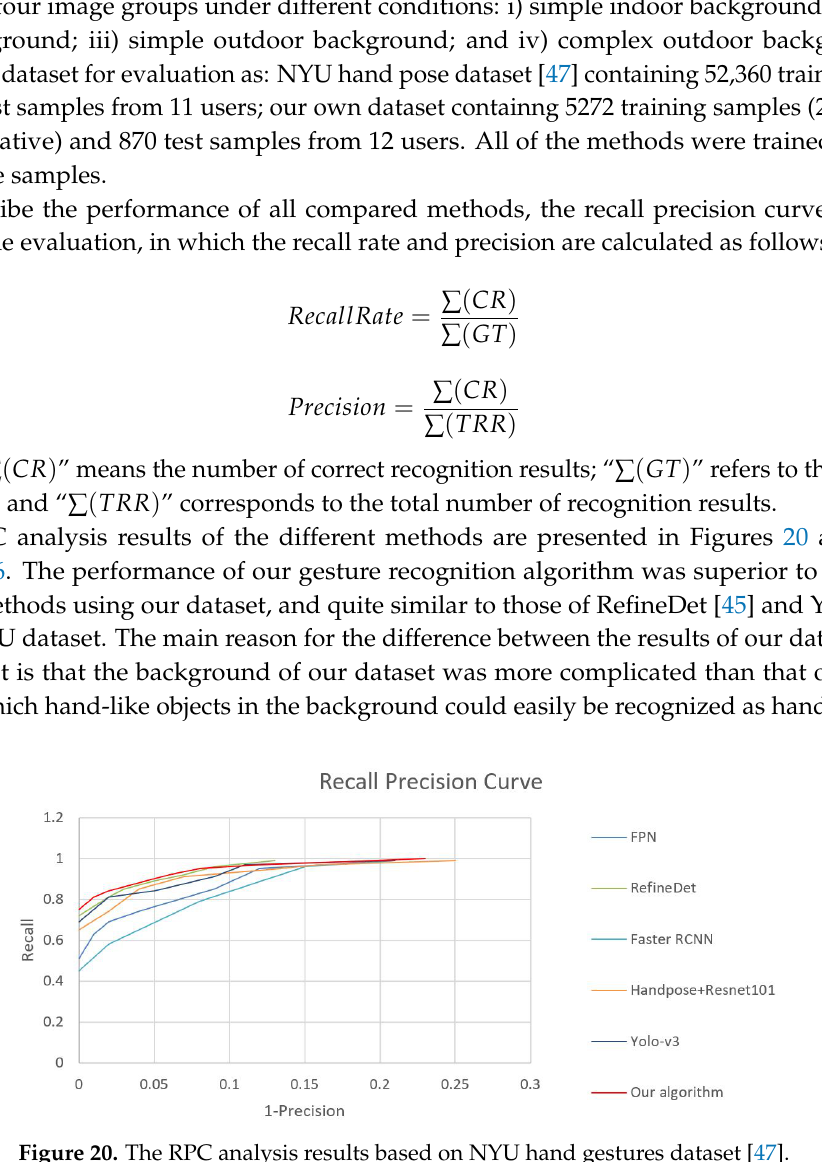
Figure 20. The RPC analysis results based on NYU hand gestures dataset